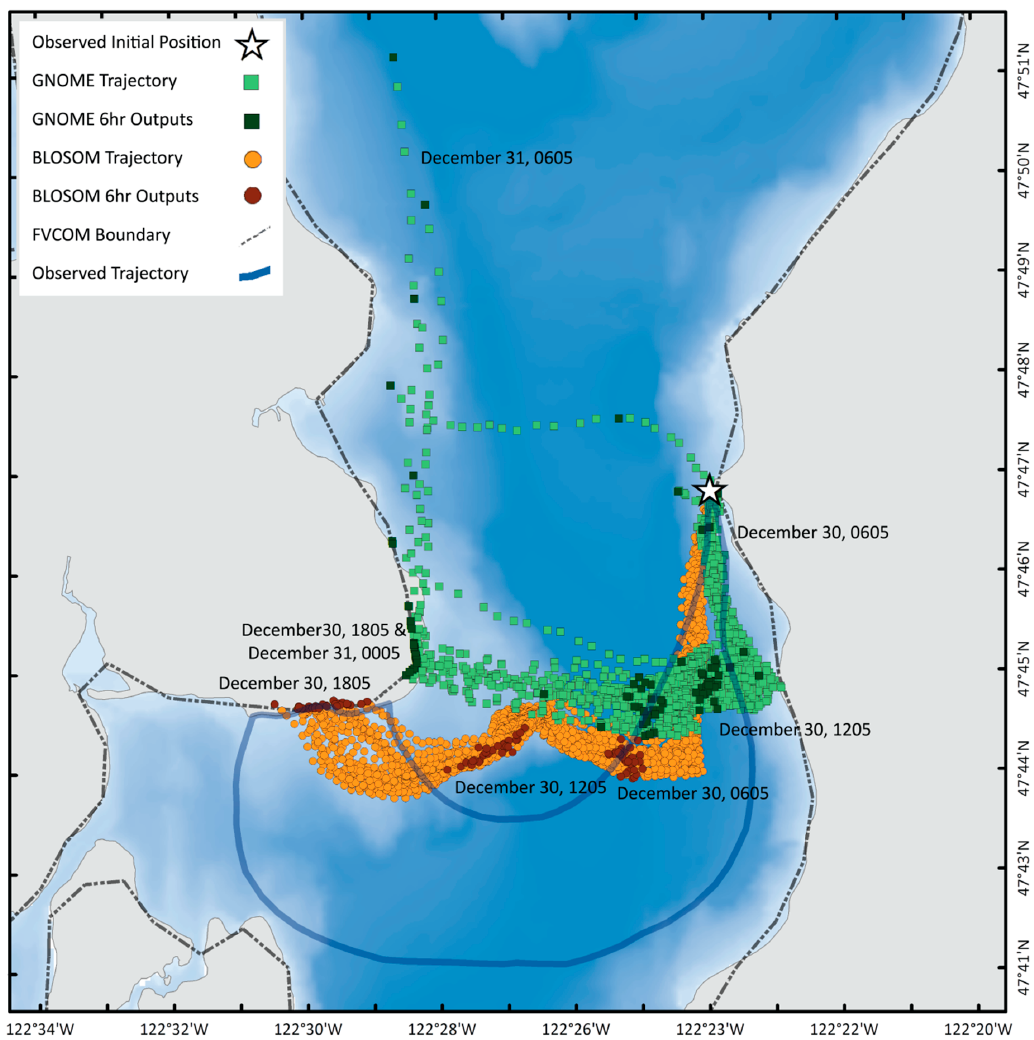
Figure 17. Simulation including diffusion with thirty particles; test 7.